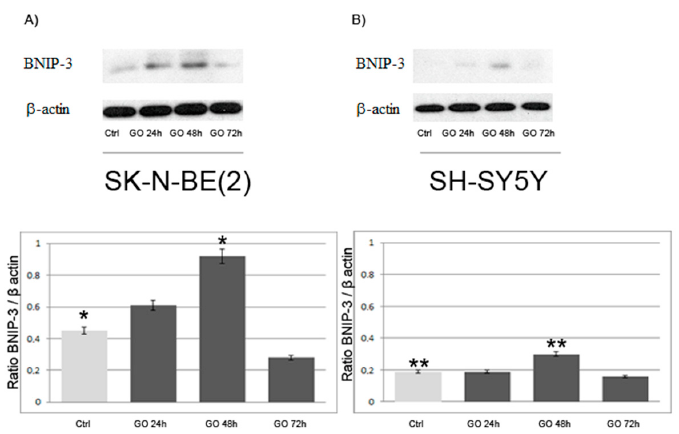
Figure 7. Expression of BNIP 3 in SK-N-BE(2) and SH-SY5Y. cells: ( A ) BNIP 3 (22 and 30 kDa) in SK-N-BE(2) and SH-SY5Y; and ( B ) at different times of incubation with GO. Densitometry was performed on bands and results are expressed as ratio protein/ β actin. Histograms represent the mean values of three independent experiments ± SD. * and ** p < 0.05 for each exposure time compared to unexposed control (CTRL).